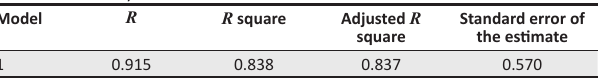
TABLE 5a: Influence of the intervening variable on the dependent variable. Model 1 summary. Model